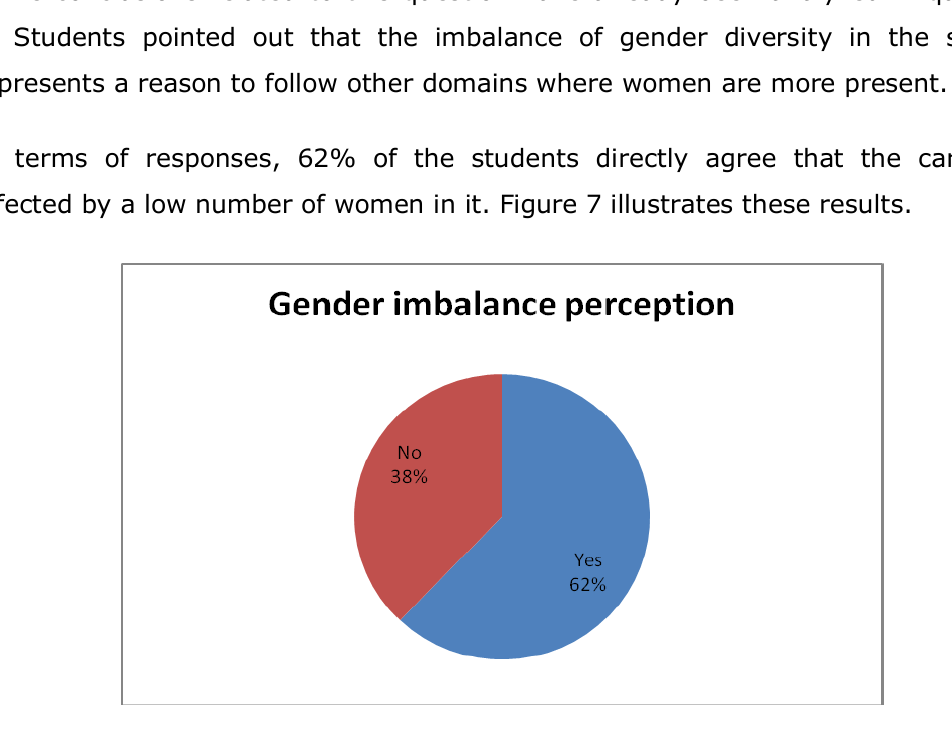
Figure 7. Perception of gender imbalance in